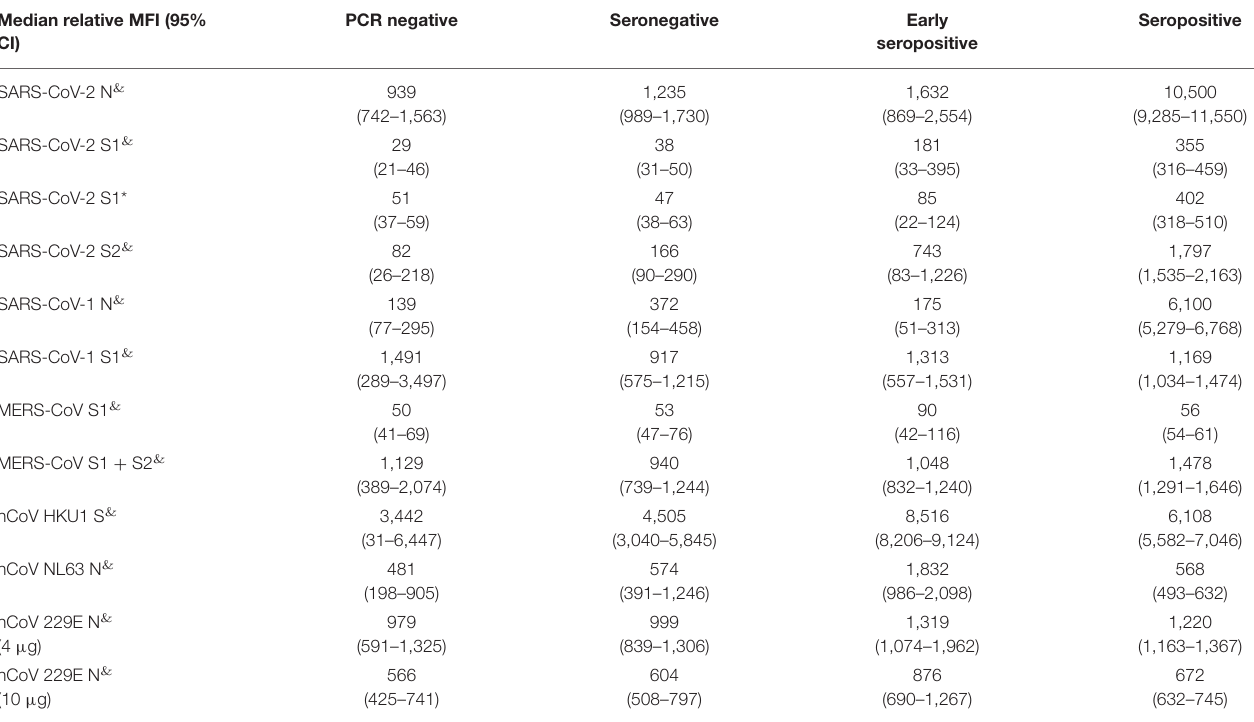
TABLE 4 | Results of multiplex antigen serological